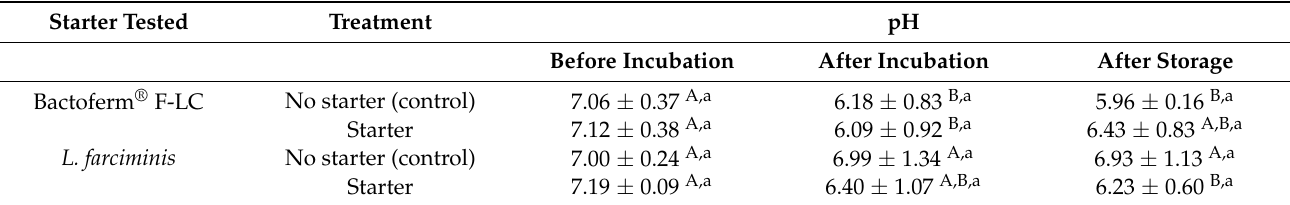
Table 1. Results of off-line pH measurements before incubation, after incubation and after cooled storage of control Scheme 3 ± standard deviation. a Means for control and starter treatment per starter tested and per measuring time point do not differ significantly when they have the same superscript (small letter). A,B Means for each individual treatment and for the three time points do not differ significantly when they have the same superscript (capital letter). Starter